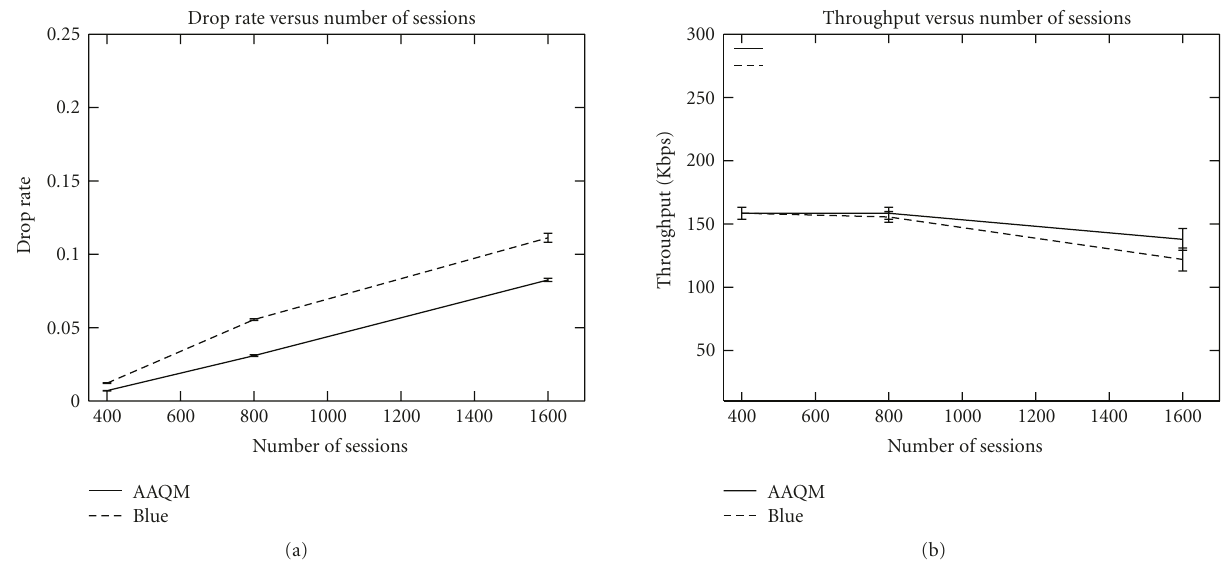
Figure 16: (a) Drop rate (b)